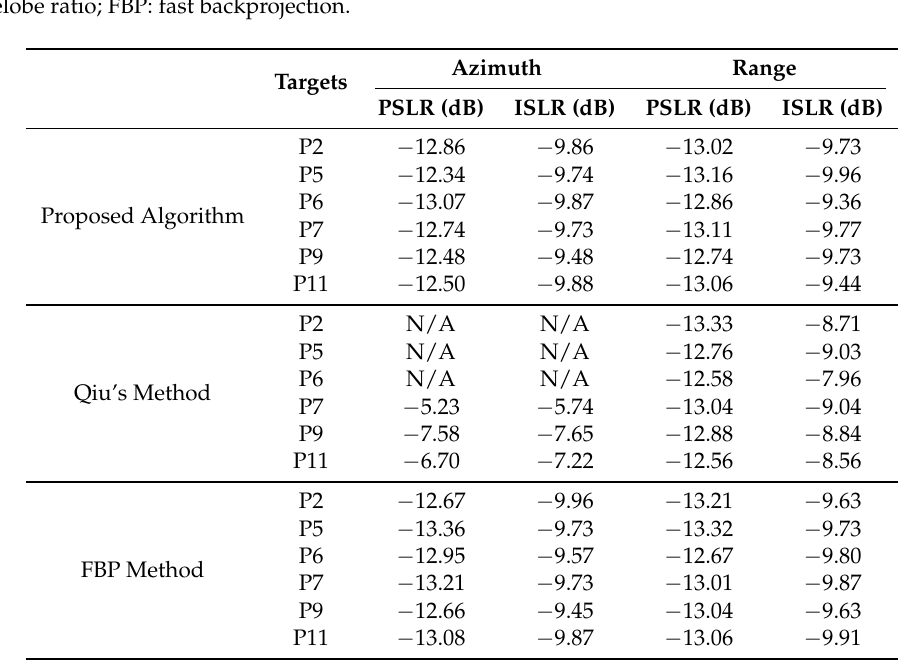
Figure 13. Imaging results of the fast backprojection (FBP) method. Table 2. Measured parameters of the selected targets. PSLR: peak sidelobe ratio; ISLR: integrated sidelobe ratio; FBP: fast backprojection.